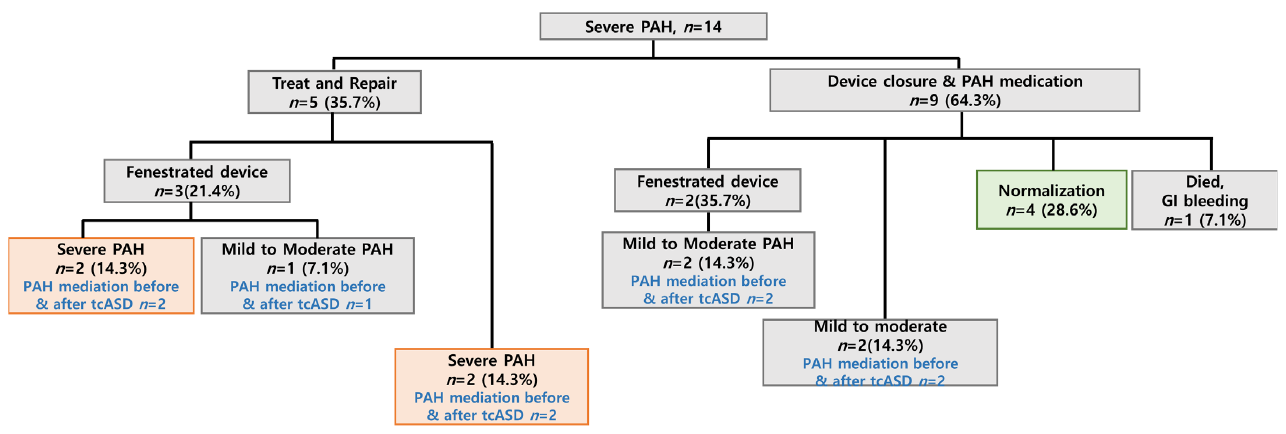
Figure 2. Treatment flow chart for patients with severe PAH. GI, gastrointestinal; PAH, pulmonary arterial hypertension.